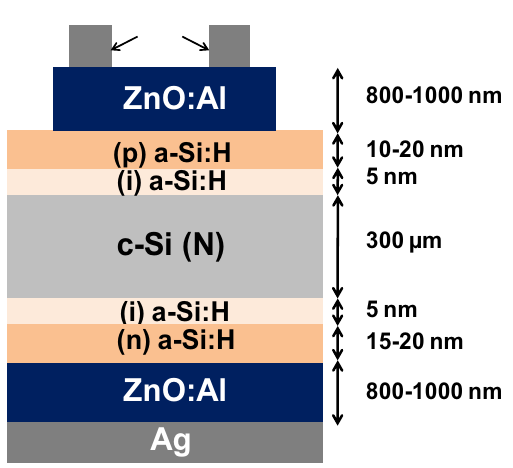
Fig. 1. Schematic of the